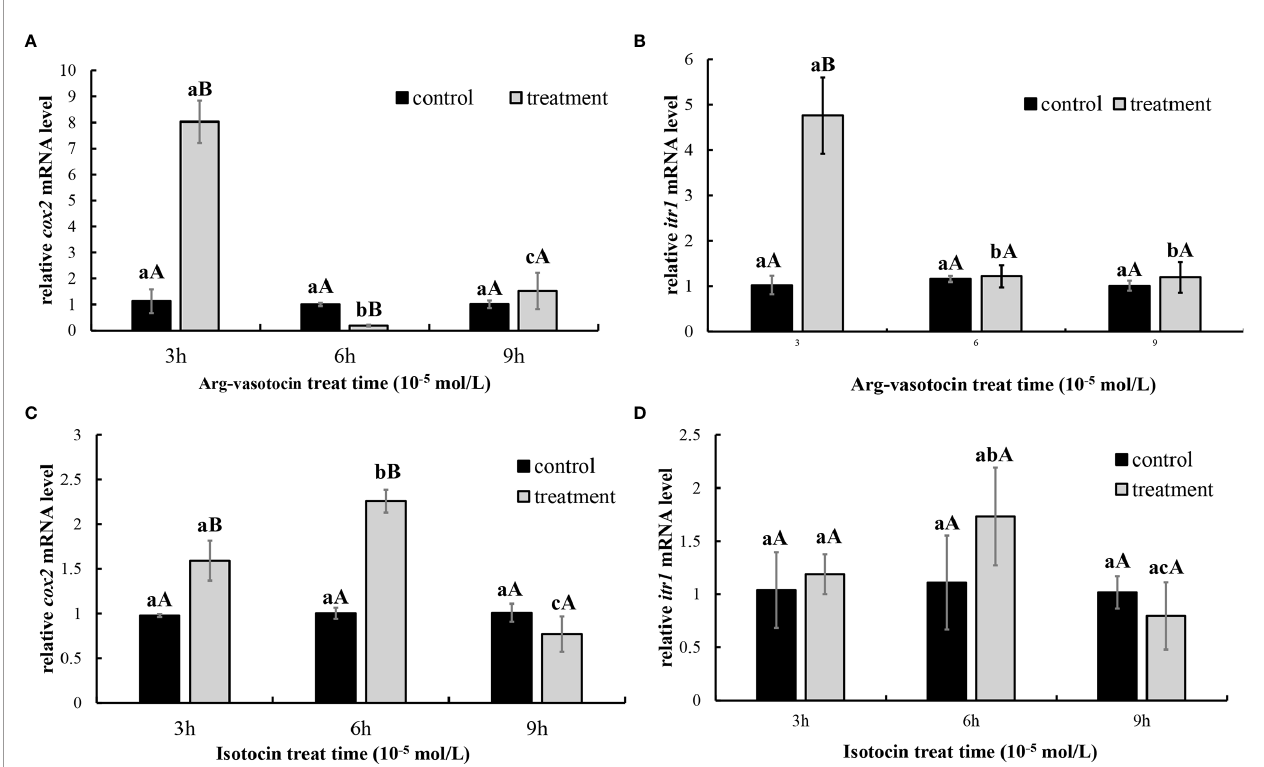
FIGURE 7 | Time-dependent effects of AVT and IT on the expression of cox2 and itr1 mRNAs in guppy ovary fragments. The levels of the cox2 and itr1 mRNAs were measured using qPCR (n=5). (A, B) Ovary fragments were incubated with AVT (10 − 5 mol/L) for 3, 6, or 9 h. (C, D) Ovary fragments were incubated with IT (10 − 5 mol/L) for 3, 6, or 9 h. The results are presented as the mean ± SEM and as fold changes in the expression levels versus the corresponding controls. Different capital letters indicate signi fi cant differences at the same time points between the treatment and control groups (P < 0.05). Different lowercase letters indicate signi fi cant differences in the corresponding control or treatment groups (P <